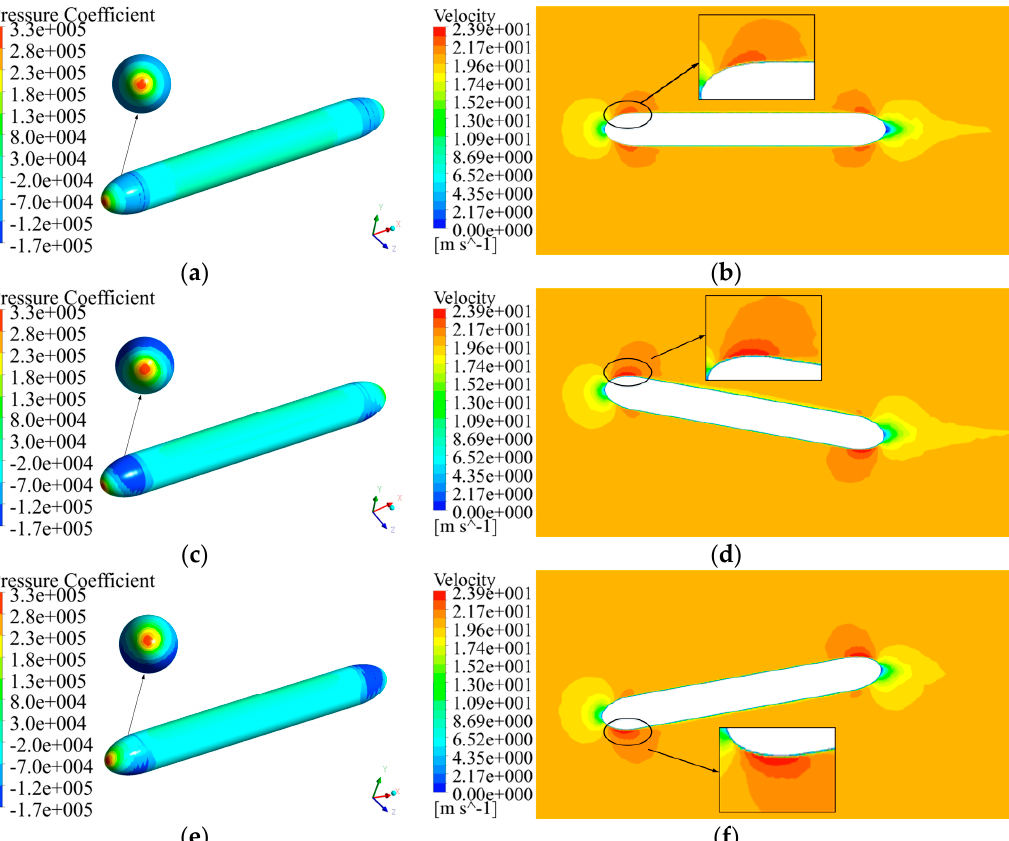
Figure 6. Different sailing postures caused by the complex oceanic environment. Figure 6. Di ff erent sailing postures caused by the complex oceanic environment.